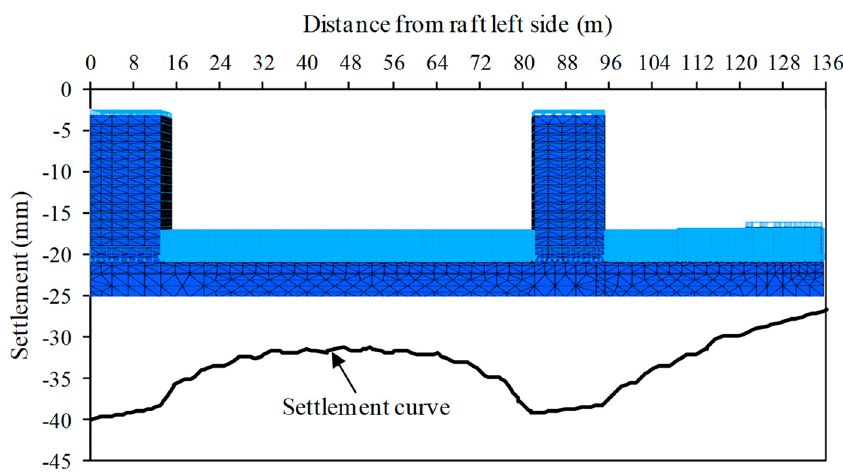
Figure 17. Settlement distribution in the center section of the raft of high-rise buildings.